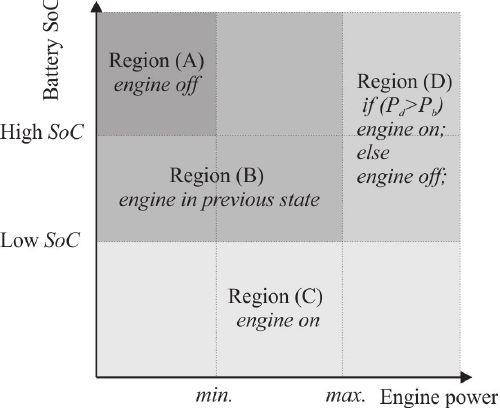
Figure 3. Engine on/off rules for power follower strategy (according to